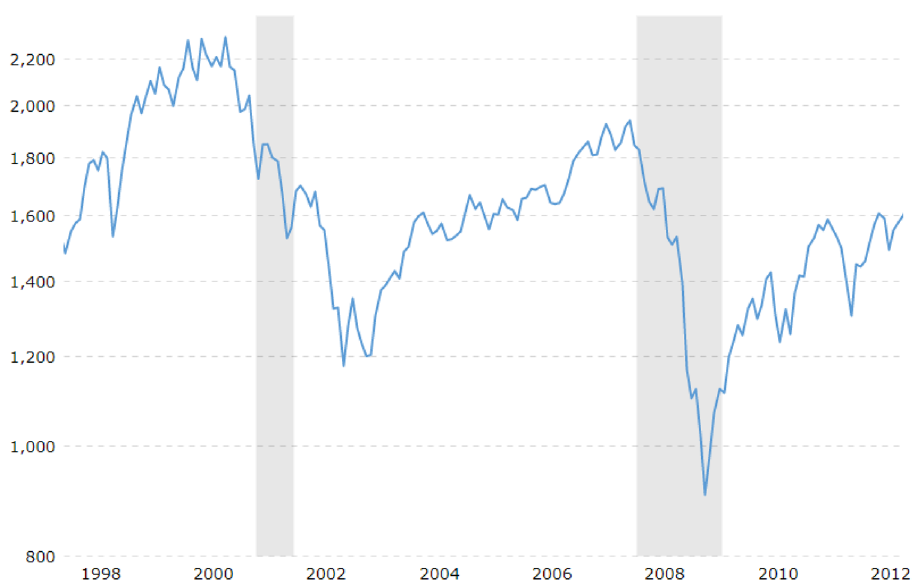
Figure 6. Historical records 35 of the S&P 500, where the dataset starts from 1998 to 2012. The shaded area indicates the financial